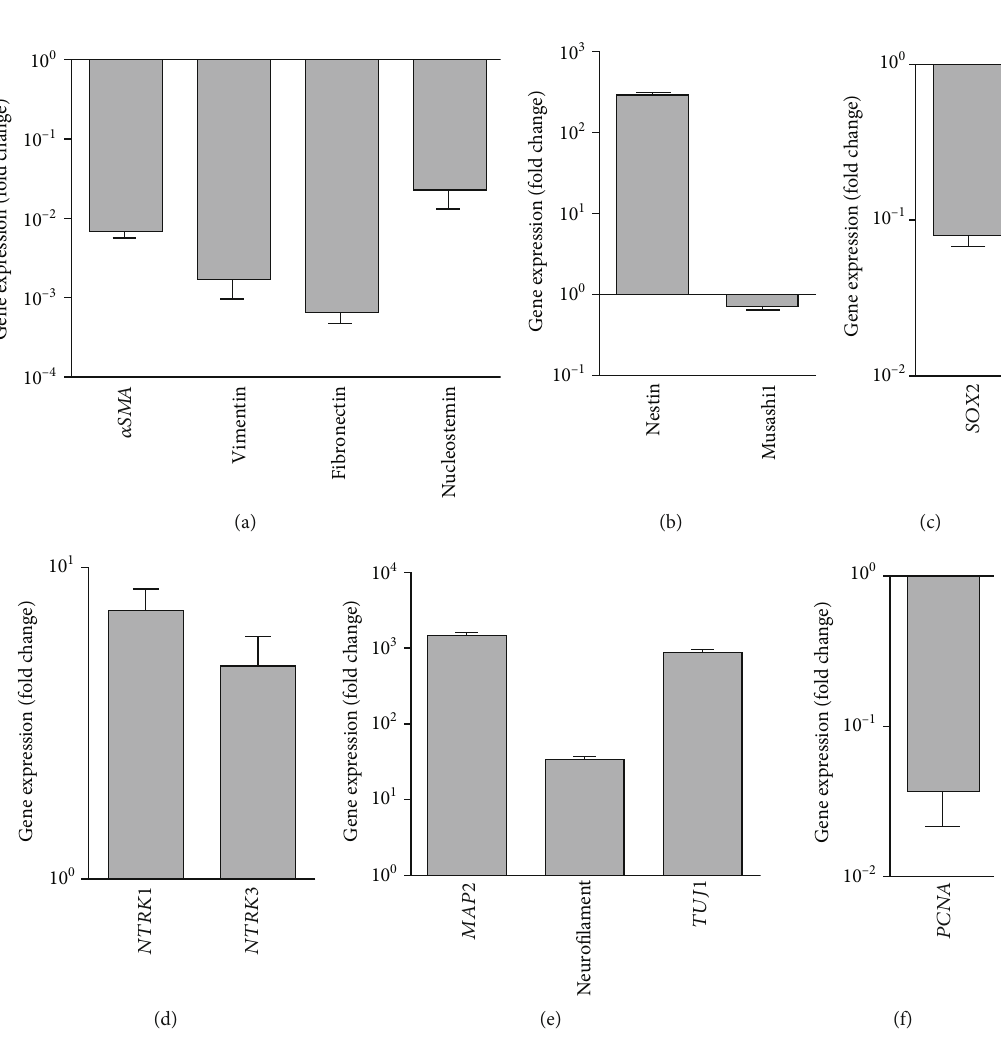
Figure 7: Gene expression pro fi le in neuronal-like cells. Panel A: expression pro fi le of MSC-speci fi c genes. Panel B: expression pro fi le of neural stem cell-speci fi c genes. Panel C: expression pro fi le of neural progenitor-speci fi c transcription factor. Panel D: expression pro fi le of neuronal receptor-speci fi c genes. Panel E: expression pro fi le of matured neuron-speci fi c genes. Panel F: expression pro fi le of cell proliferation speci fi c gene. GAPDH was used as normalization control. Shown here is the relative fold change in the gene expression of various MSCs and neuronal lineage-speci fi c genes in the WJ-MSCs derived neuronal-like cells relative to WJ-MSCs ( mean ± SEM , n = 4